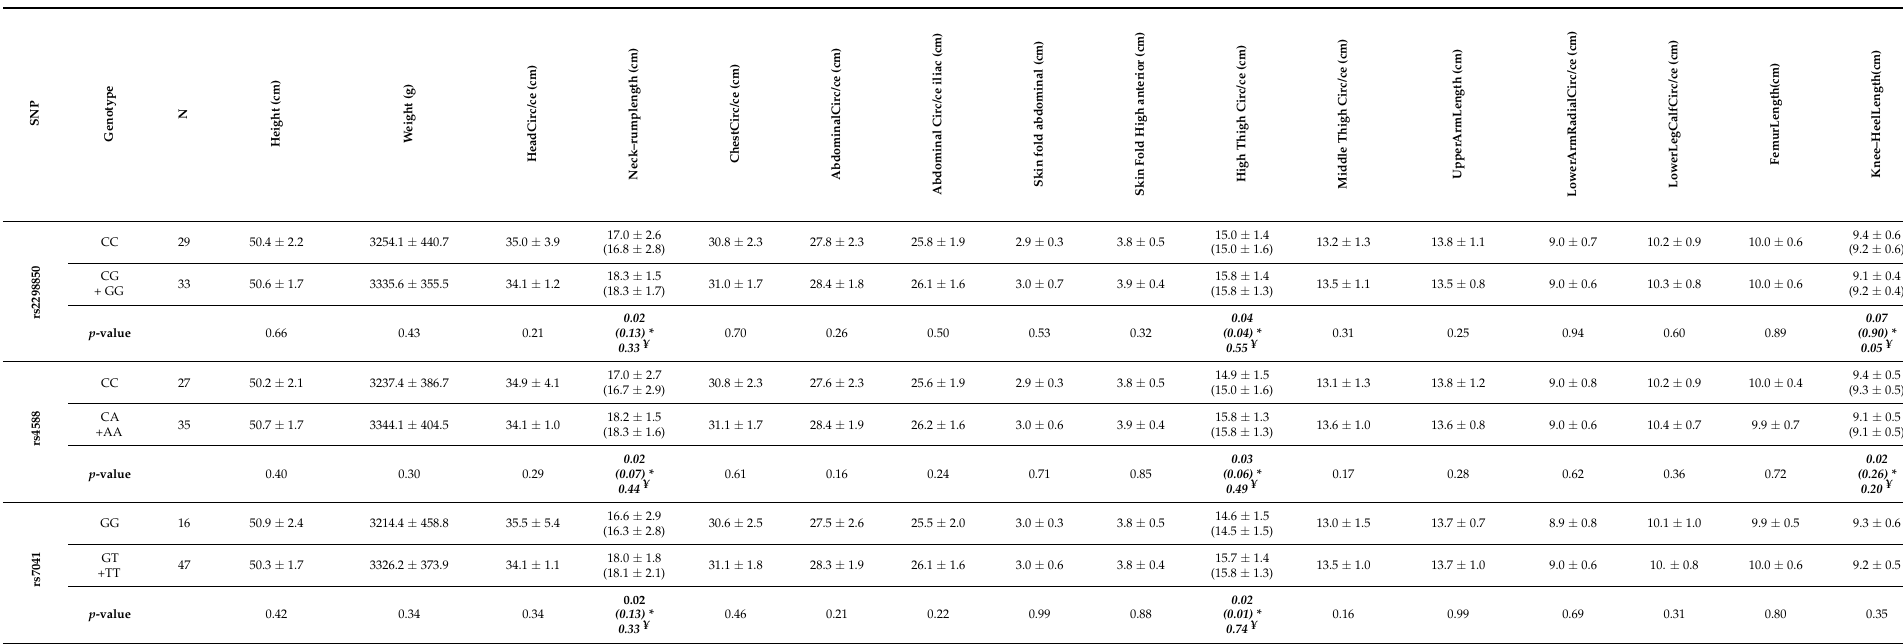
Table 6. Birth neonatal anthropometry (neonatal 25(OH)D ≤ 50 nmol/L) according to neonatal VDBP polymorphisms . If Levene’s Test for Equality of Variances p > 0.05 then Equal variances assumed Sig (2-tailed) p -values of T-Tests were given. If Levene’s Test for Equality of Variances p < 0.05 then Equal variances not assumed Sig (2-tailed) p -values of T-Tests were given. * The data and p -values adjusted for maternal height (cm), BMI pre-pregnancy (kg/m 2 ), BMI terminal (kg/m 2 ), and weeks of gestation by One-way analysis of covariance (ANCOVA) Numbers in italics are after adjustments. ¥ Observed power